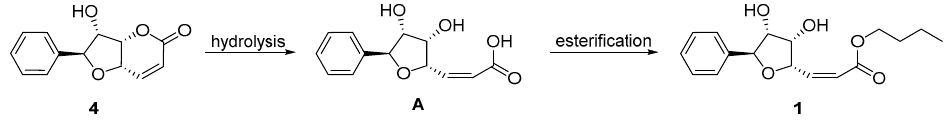
Figure 3. The plausible biosynthetic pathway of 1 from 4. Compound 2 was isolated as a white amorphous powder with [ α ] 24 ‒ 10 ( c 0.05, D MeOH). The high-resolution ESIMS data showed a protonated molecule peak at [M + H] + at m / z 336.18067, which indicated the molecular formula of C 18 H 25 NO 5 and seven degrees of unsaturation. The IR spectrum of 2 showed absorption bands at 1736 and 1671 cm − 1 , revealing the presence of ester and amide functionality. The 1 H NMR data (Table 2) of 2 possessed the signals of one monosubstituted benzene ring [ δ H 7.29 (2H, m, H-3/H-5), 7.31 (m, H-4), and 7.37 (2H, m, H-2/H-6)], two methylenes [ δ H 4.02 (q, J = 7.1 Hz, H-1 (cid:48)(cid:48)(cid:48) ) and δ H 4.19 (q, J = 7.1 Hz, H-1 (cid:48)(cid:48) )], and two methyl groups [ δ H 0.93 (t, J = 7.4 Hz, H-4 (cid:48)(cid:48)(cid:48) ) and δ H 1.24 (t, J = 7.1 Hz, H-2 (cid:48)(cid:48) )]. The 13 C NMR and DEPT spectra exhibited eighteen carbons, including two ester carbonyls ( δ C 170.5 and 170.8), one amide carbonyl ( δ C 170.7), one olefinic quaternary carbon ( δ C 134.4), five olefinic methines ( δ C 127.4, 128.9, 128.9, 129.3, and 129.3), two oxymethylenes ( δ C 61.8 and 64.9), one N -bearing methine ( δ C 48.6), four methylenes ( δ C 19.0, 36.2, 30.4, and 43.6), and two methyl groups ( δ C 13.6 and 14.0). The planar structure of 2 was elucidated by dividing it into three partial structures, X, Y, and Z (Figure 2). A proton spin system of H-2 ( δ H 7.37)/H-3 ( δ H 7.29)/H-4 ( δ H 7.31)/H-5 ( δ H 7.29)/H-6 ( δ H 7.37) was observed from the COSY spectrum. In the HMBC spectrum, H 2 -7 ( δ H 3.62) showed correlations to C-1 ( δ C 134.4) and C-8 ( δ C 170.7), and the correlation from H-2/H-6 to C-1 revealed the presence of partial structure X. For the partial structure Y, a butyl group attached to an ester group was identified by the COSY correlations of H-1 (cid:48)(cid:48)(cid:48) ( δ H 4.02)/H-2 (cid:48)(cid:48)(cid:48) ( δ H 1.54)/H-3 (cid:48)(cid:48)(cid:48) ( δ H 1.33)/H-4 (cid:48)(cid:48)(cid:48) ( δ H 0.93) and the HMBC correlations from H 2 - 3 (cid:48) ( δ H 2.82 and 3.00) and H-1 (cid:48)(cid:48)(cid:48) to C-4 (cid:48) ( δ C 170.8). Additionally, the HMBC correlations from H-1 (cid:48)(cid:48) ( δ H 4.19) to C-1 (cid:48) ( δ C 170.5), along with the proton spin system between H-1 (cid:48)(cid:48) ( δ H 4.19) and H-2 (cid:48)(cid:48) ( δ H 1.24) established the partial structure Z. These three parts were connected by the HMBC correlations from H-2 (cid:48) ( δ H 4.83) to C-8, C-1 (cid:48) , and C-4 (cid:48) . According to the above 2D NMR analyses, the planar structure of 2 was established (Figure 2). Structurally, 2